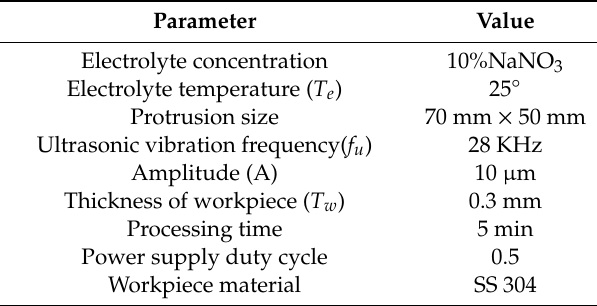
Table 1. Processing